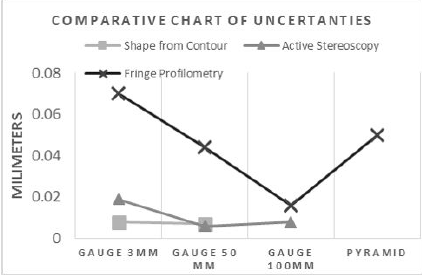
Figure 14. 3D reconstruction of the blocks, axis are at Figure 16. Comparative chart for uncertainties. X-axis shows centimeters. the measured objects and Y-axis the uncertainties at mm